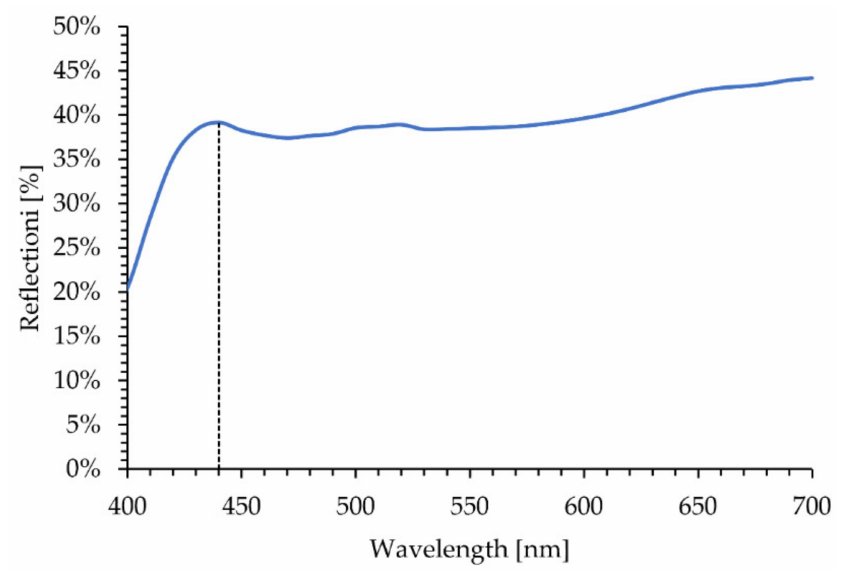
Figure 12. Reflection curve of Ni/Y 2 O 3 nanocomposite coating, obtained with CIELAB